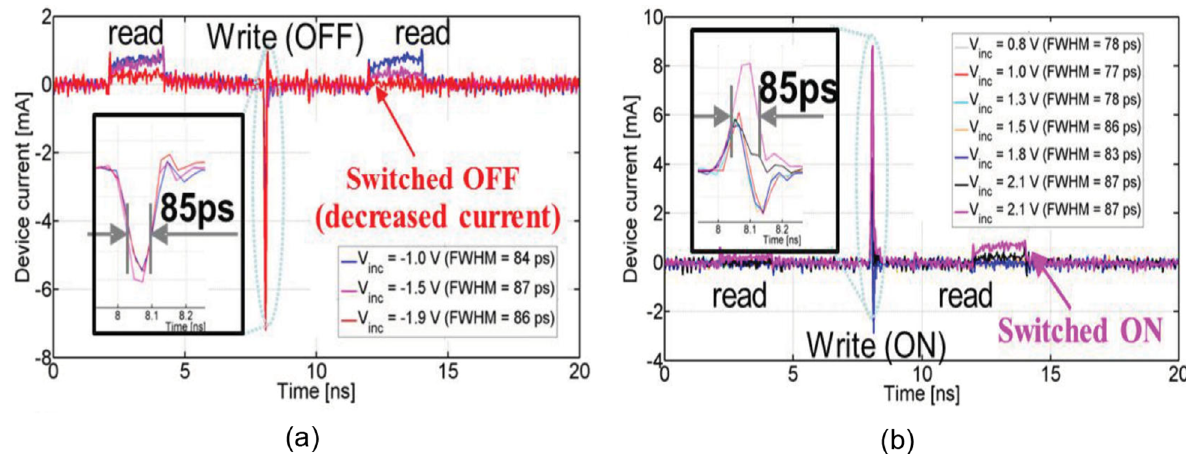
Fig. 9 a 85-ps voltage pulse OFF Switching. b 85-ps voltage pulse ON Switching. FWHM means full width at half maximum. Reproduced with permission from